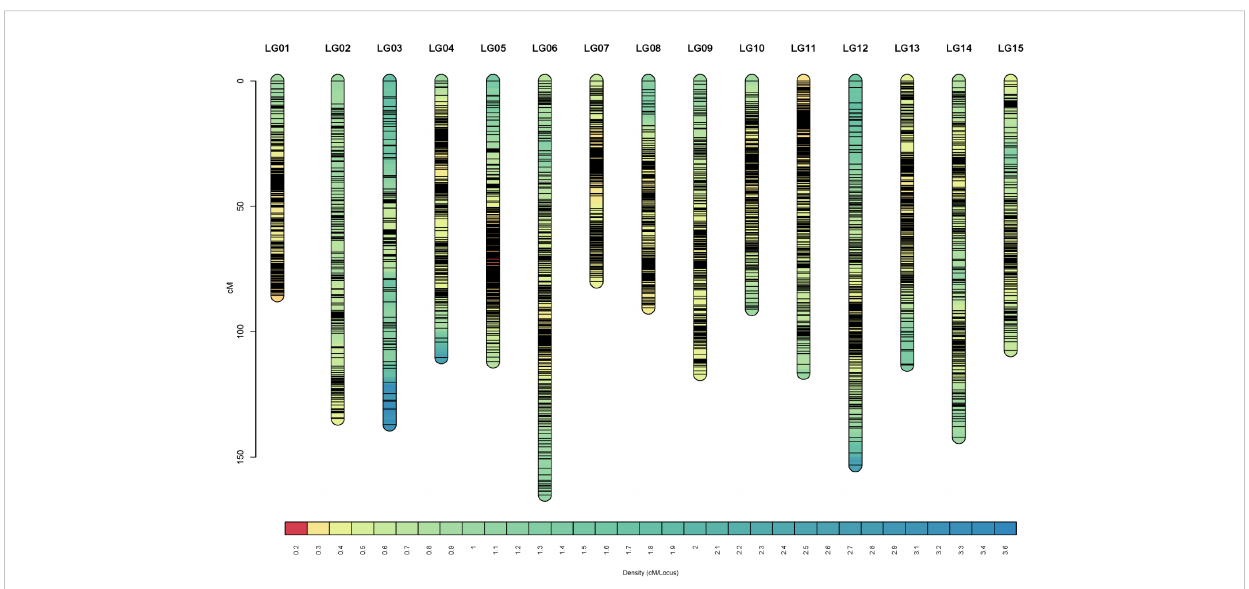
FIGURE 1 Marker distribution across the linkage map. The x-axis, y-axis, and lines in the column represent the linkage group, genetic distance, and unique marker,